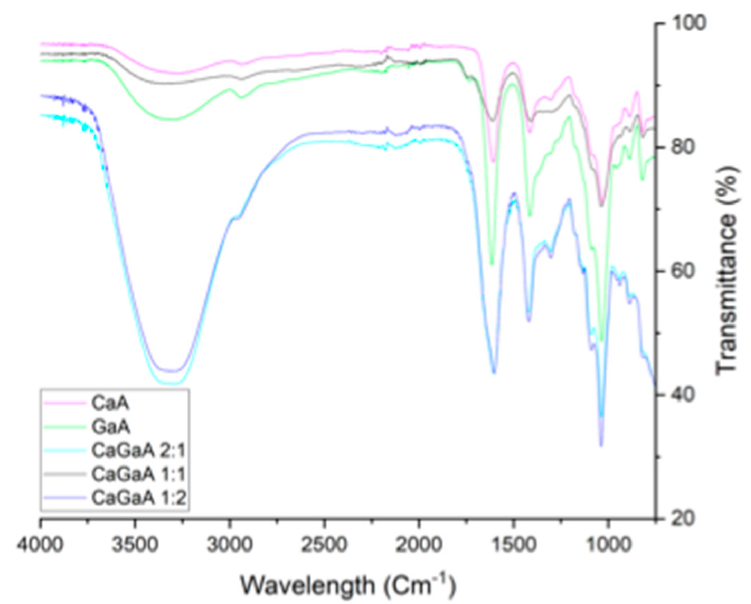
Figure 6. FTIR values between calcium alginate, gallium alginate, calcium gallium alginate 1:1, calcium gallium alginate 1:2 and calcium gallium alginate 2:1.